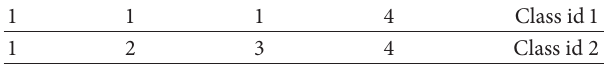
Table 3: Assumed class id for 𝐾 -nearest neighbor algorithm.